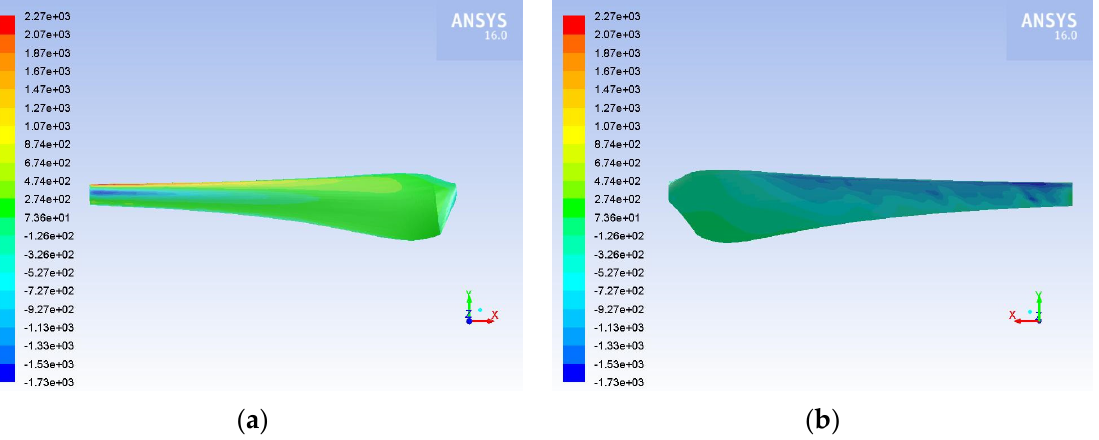
Figure 7. Contours of pressure on ( a ) the pressure; ( b ) the suction side of the blade for airflow and air velocity equal to 10 m·s − 1 .